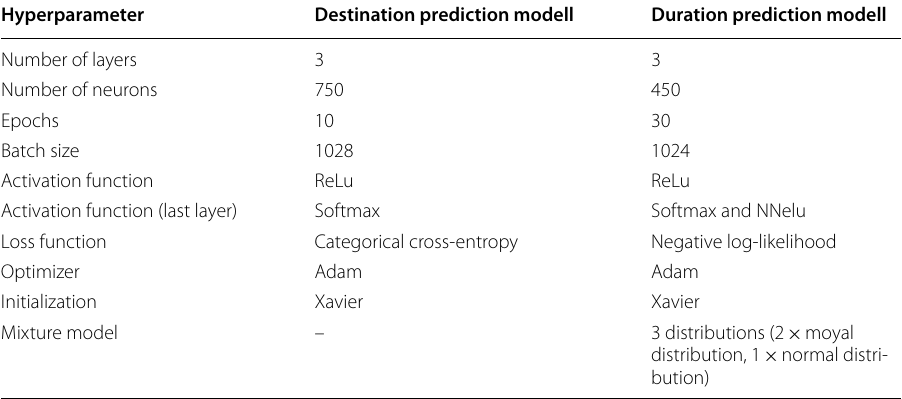
Table 2 Hyperparameters of the best-performing neural networks. Source :